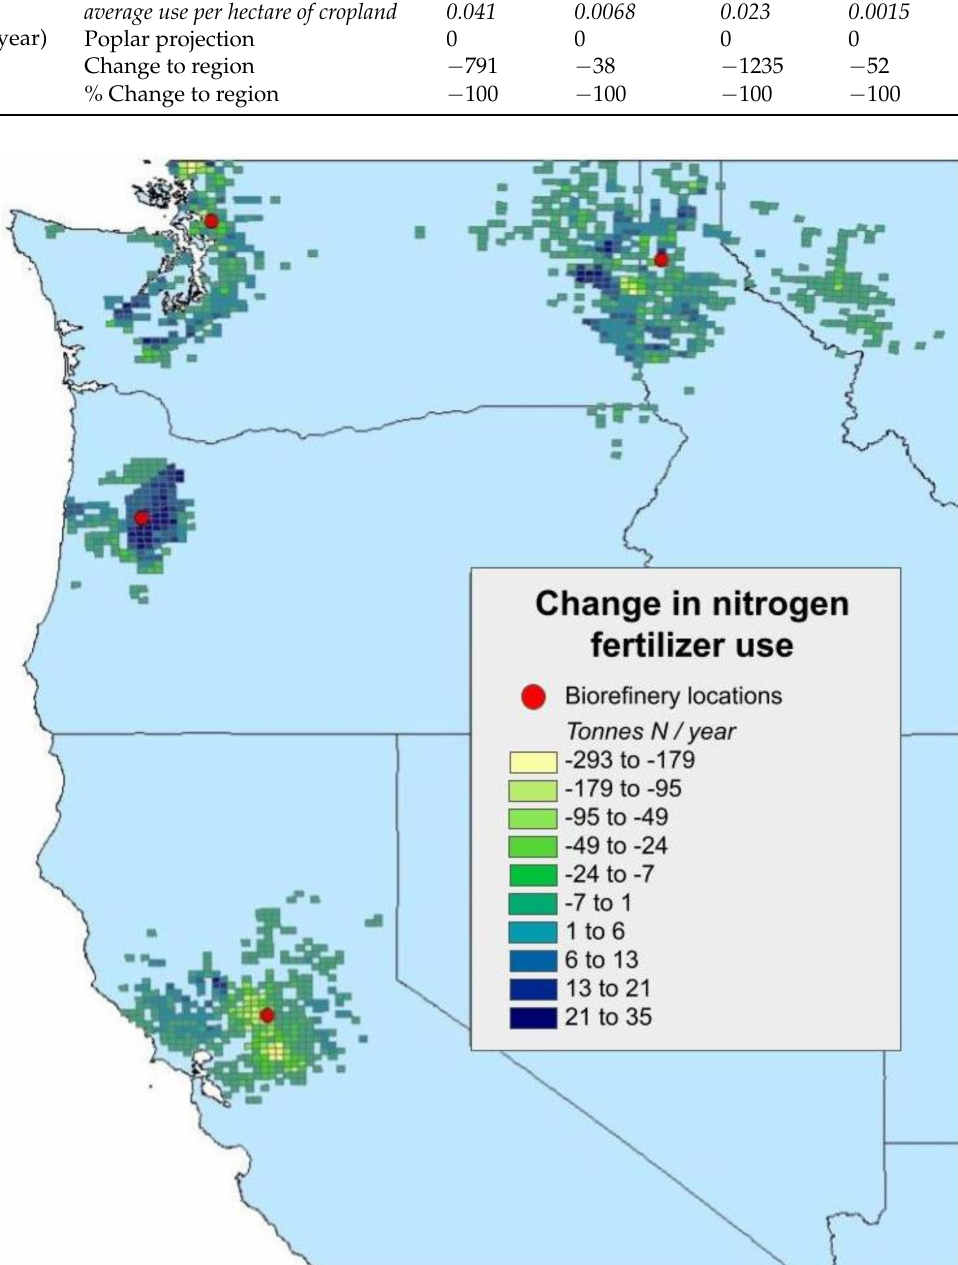
Figure 2. Change in nitrogen fertilizer use for each pixel as a result of switching from current practices to growing poplar trees for bio-jet fuel production. Green to yellow indicates a decrease in nitrogen use when switching to poplar. Light blue to dark blue indicates an increase in nitrogen